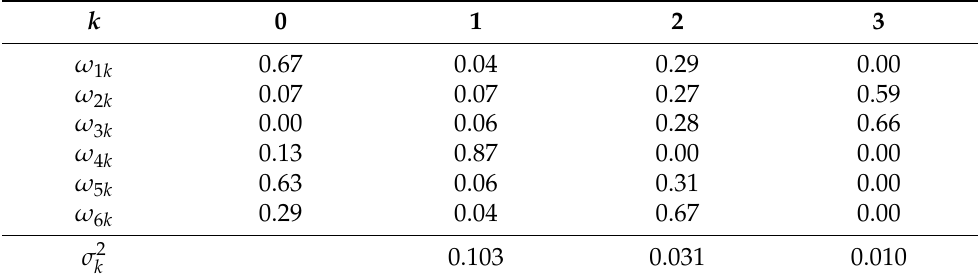
Table 8. The complete set of parameters ˆ W , ˆ σ 2 Γ necessary to specify the dependence structure in CreditRisk + model, obtained by the eigenvalues decomposition of ˆ A ( E ,4 ) ( 0,1 ) , as reported in Table